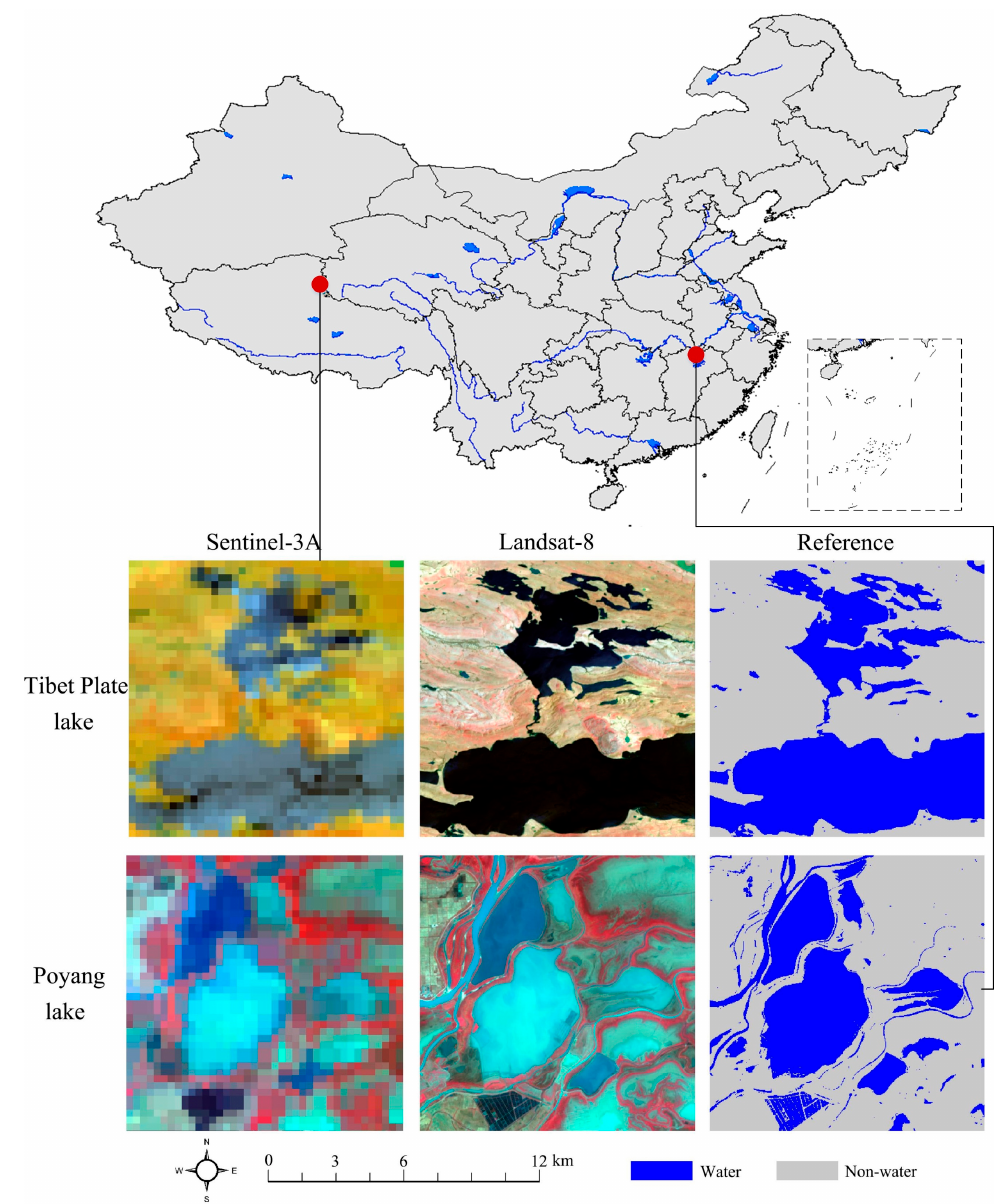
Figure 3. Sentinel-3A (RGB20-10-5) OLIC image, Landsat-8 (RGB5-4-3) multi-spectral image and reference water body maps for the Tibet Plate lake and Poyang lake.